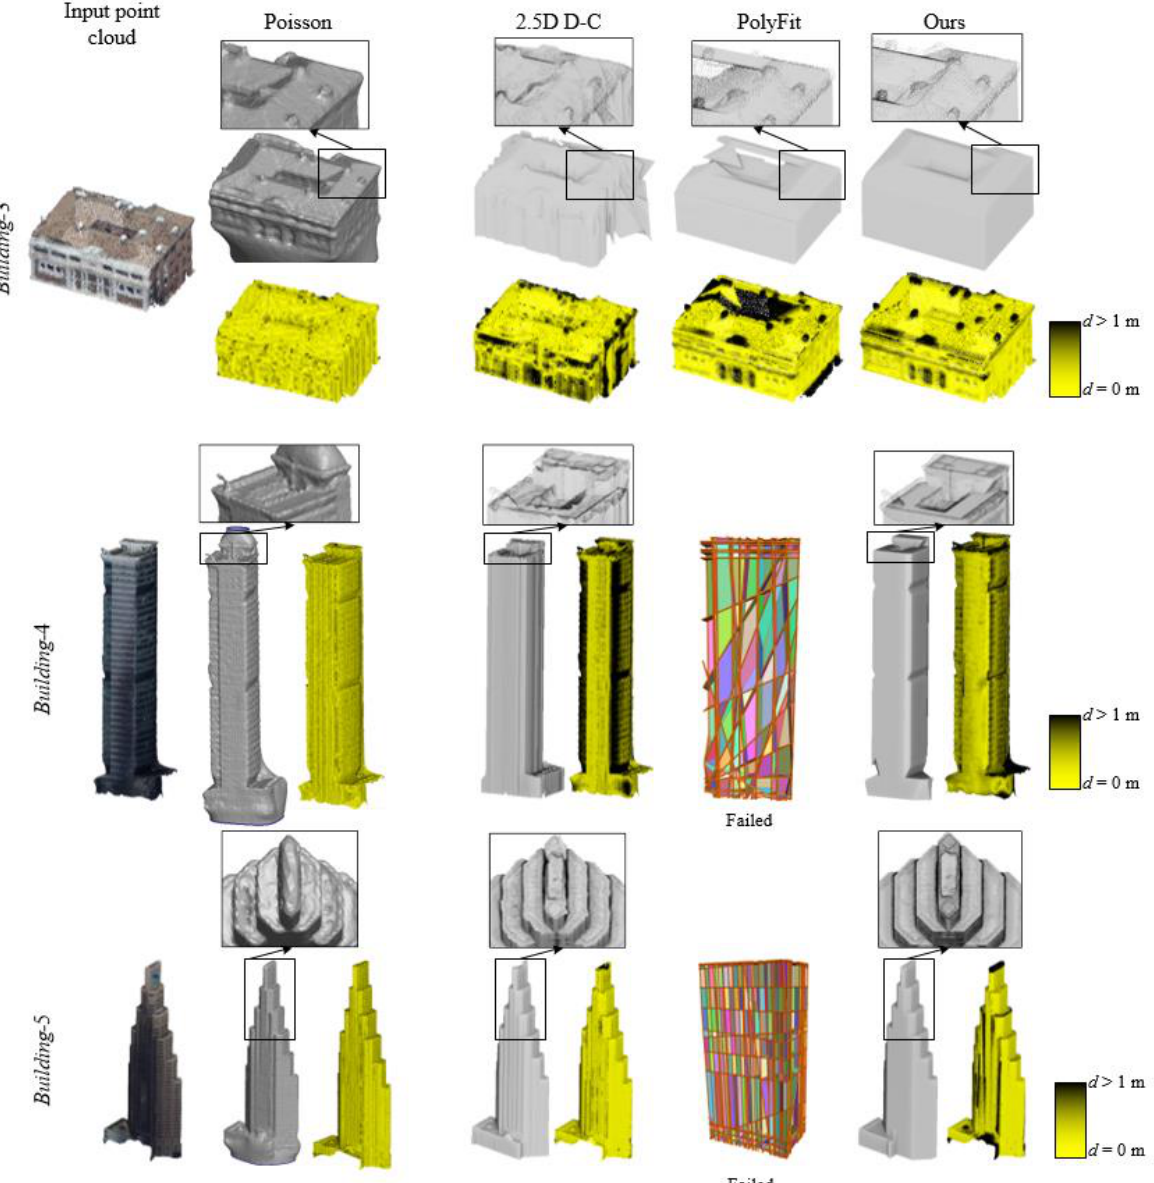
Figure 10. Evaluations of reconstruction results of three complex buildings and comparison with the results of Poisson, 2.5D D-C and PolyFit. Details of the reconstructed building rooftops are shown in the black rectangles, where the input point clouds are overlapped on the building